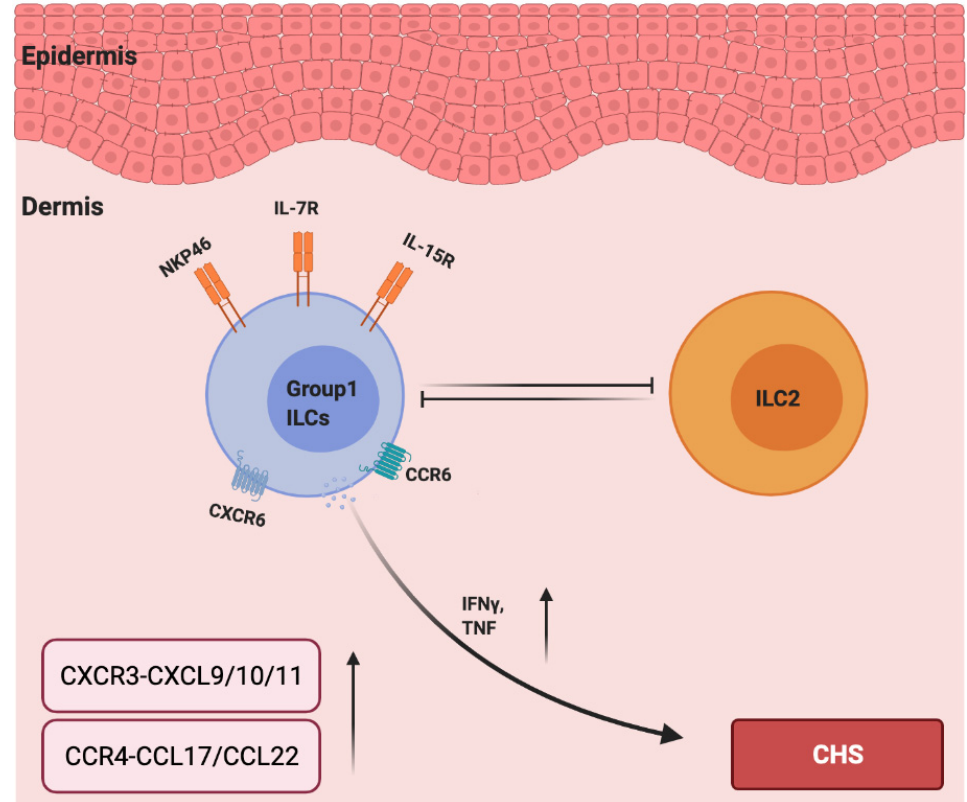
Figure 2. The roles of chemokines and group 1 ILCs in the pathogenesis of allergic contact hyper- sensitivity. IL-7 and IL15 are required for the development of group 1 ILCs. CCR6 and CXCR6 are essential for NK cell homing to inflamed skin, and NKP46 is a major activation receptor of NK cells. NK cells negatively regulate ILC2s, and ILC2s counter regulate type 1 immune responses (IFN- γ and TNF- α ) and are mainly driven by group 1 ILCs. The levels of CXCR3–CXCL9/10/11 and CCR4– CCL17/CCL22 are upregulated in the lesions due to CHS.